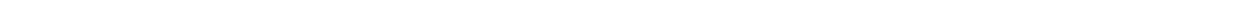
Fig. 3 Estimates of relative contact tensions. a – c Estimates based on the geometry of cell doublets. a Diagram of cell doublet, representing the balance between Ct A , Ct B and T Ab . φ AB is the angle formed between Ct A and Ct B. The orange layer symbolises the actomyosin cortex. A curved cell – cell interface re fl ects unequal Ct A and Ct B tensions. b Examples of homotypic and heterotypic doublets, expressing membrane-targeted GFP or Cherry. Scale bar, 15 µ